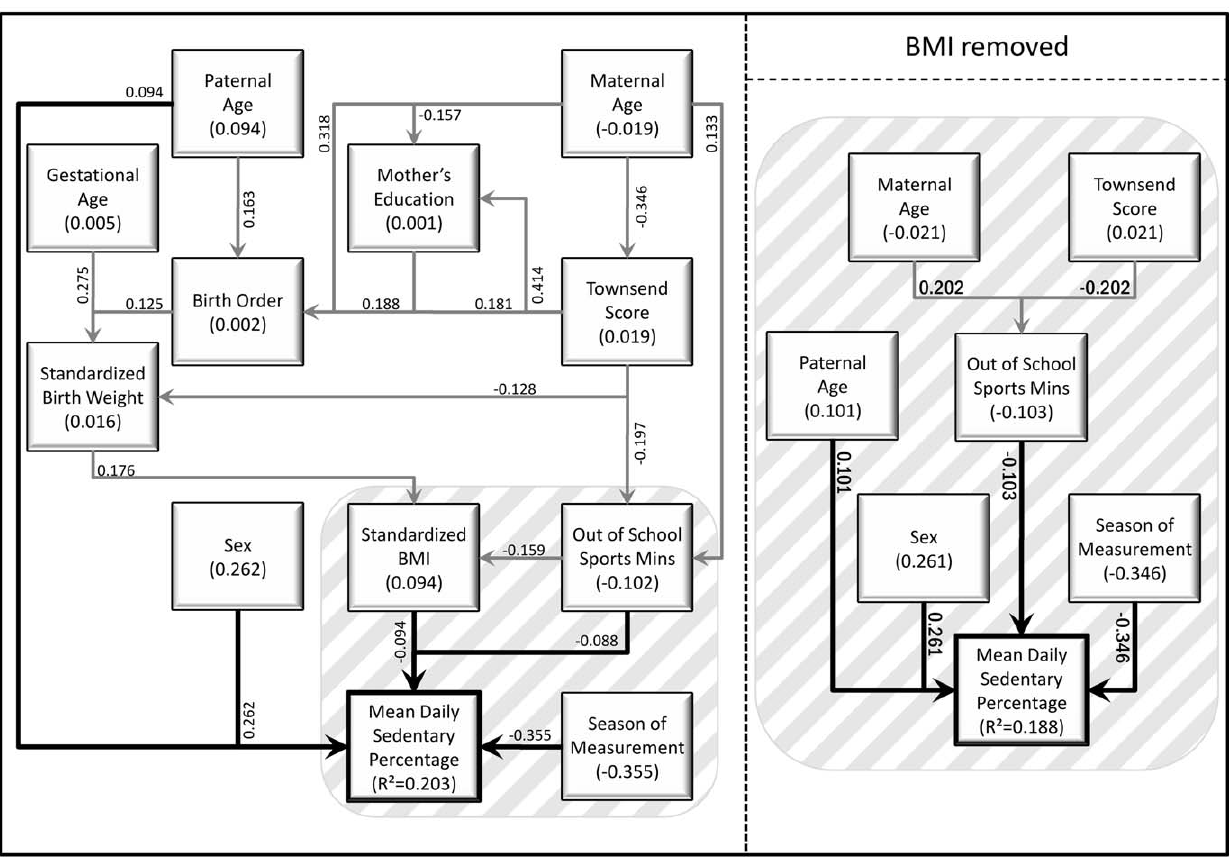
Figure 3. Path diagrams showing the direct and indirect predictors of percent of time spent in sedentary behaviour, with and without the inclusion of standardised BMI of the child.